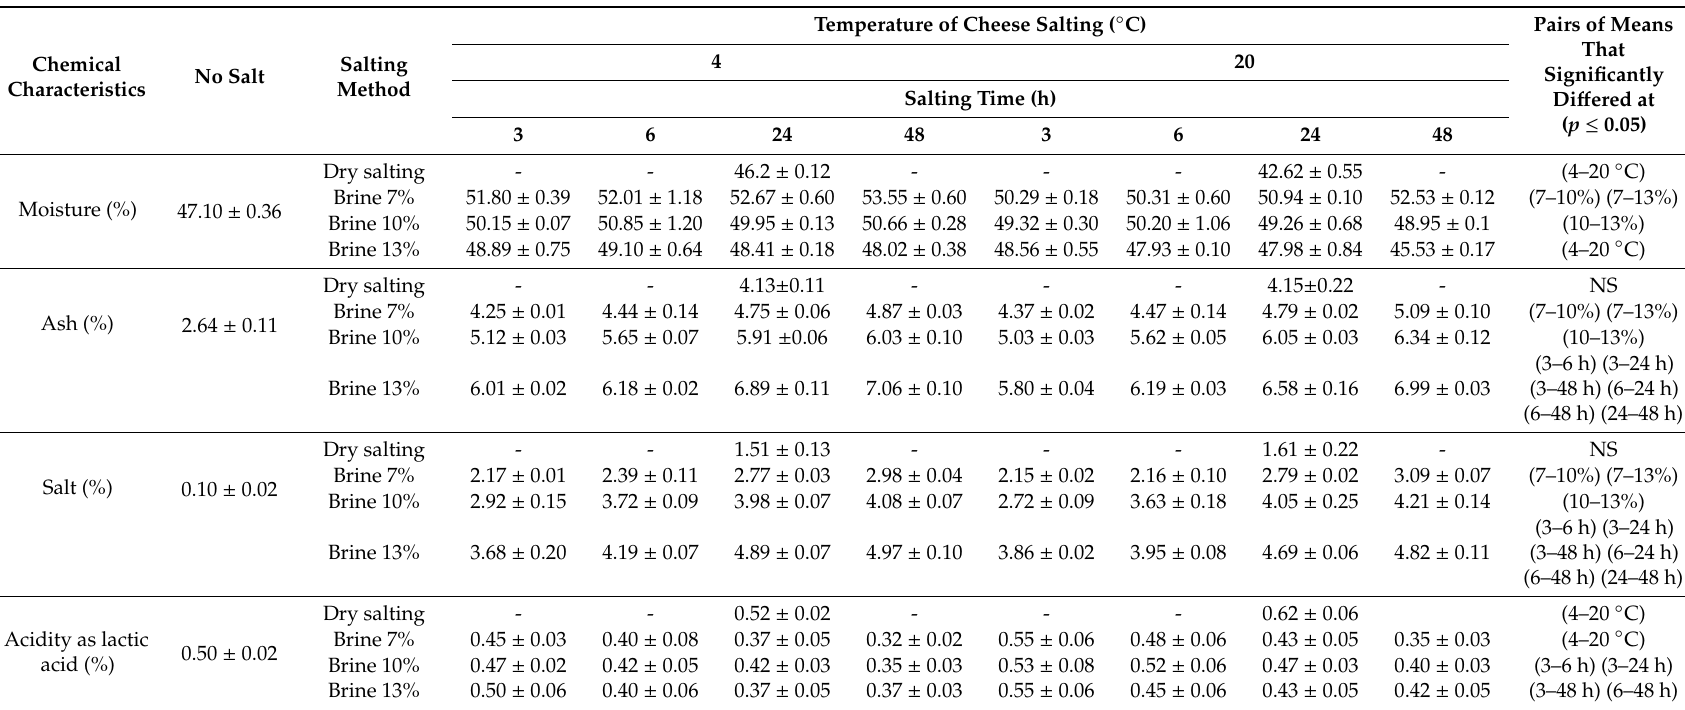
Table 1. Physicochemical characteristics of Halloumi cheese salted by di ff erent methods at 4 and 20 ◦ C for di ff erent times (means of three trials ±